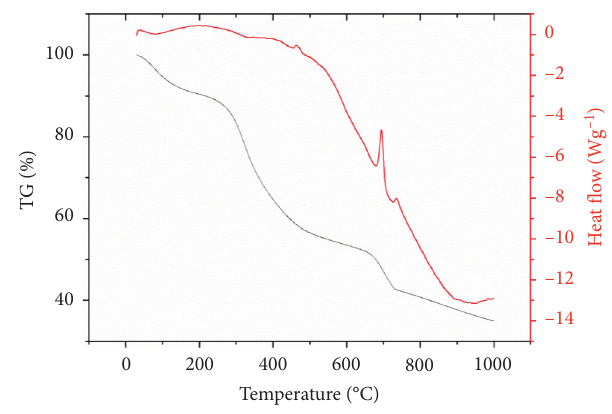
Figure 11: TG-DSC spectra of sample